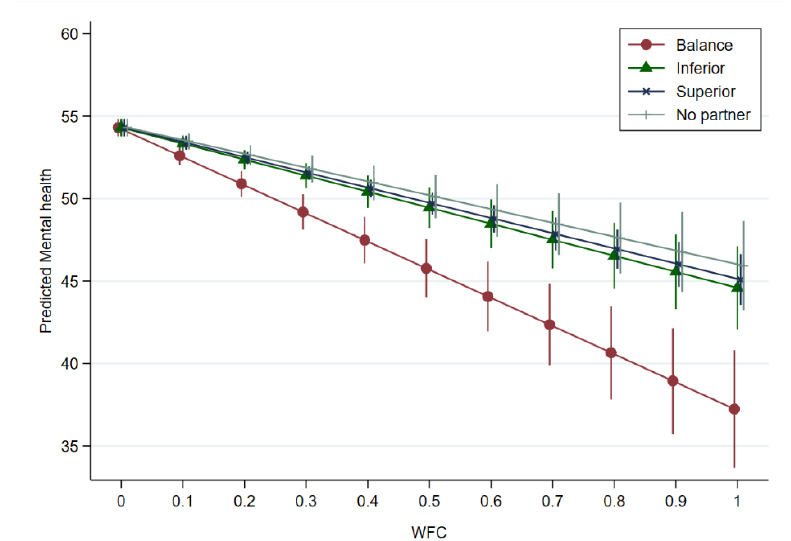
Interaction plots for WFC#Relative negotiating